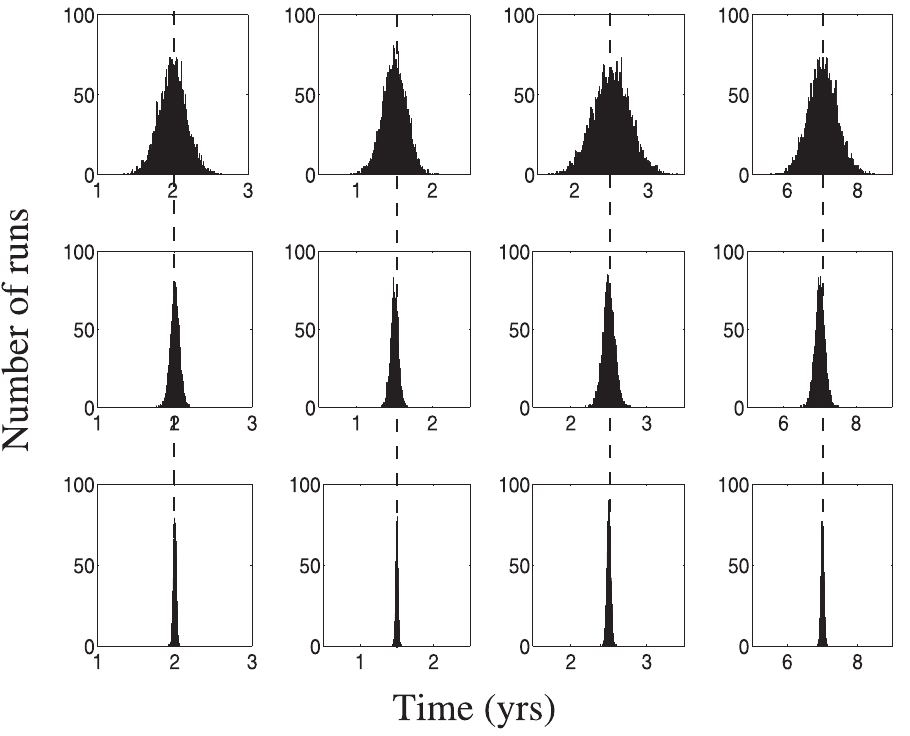
Figure 2. Regression method: the mean stage durations for data generation method 1. Sets of 1,000 (top row), 10,000 (middle row) and 100,000 (bottom row) patients were considered. Each column presents the calculated mean for 10,000 simulations for each stage of a 4-stage disease. The true mean values are shown by dashed vertical lines. doi:10.1371/journal.pone.0028298.g002 PLoS ONE |